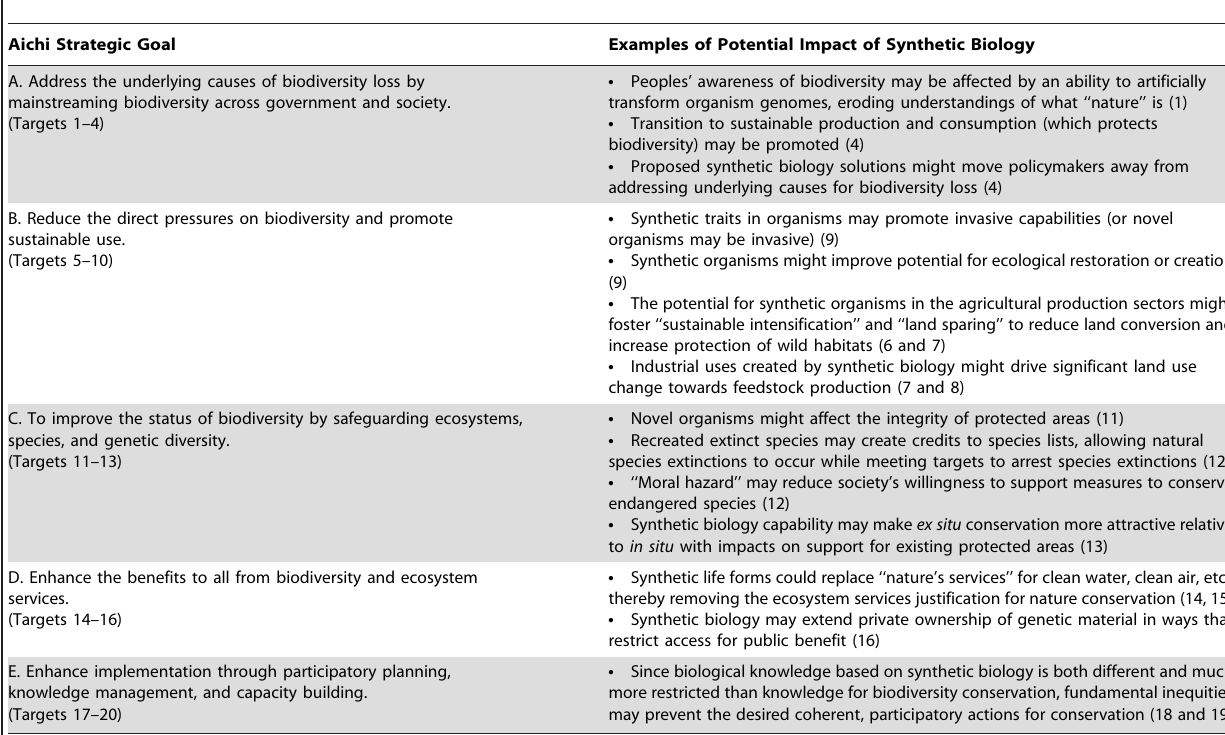
Table 1. Examples of how synthetic biology, promised or developed at even modest scales, could significantly affect the Aichi Biodiversity